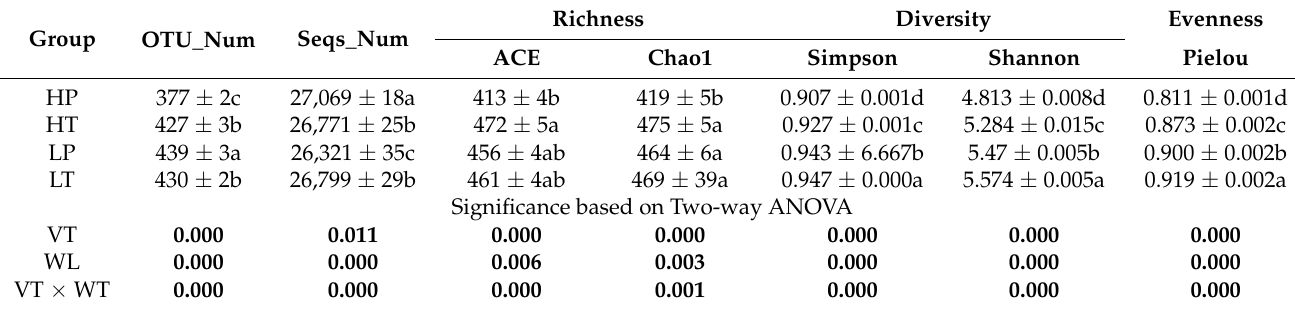
Table 3. The α -diversity index of fungi in different groups.